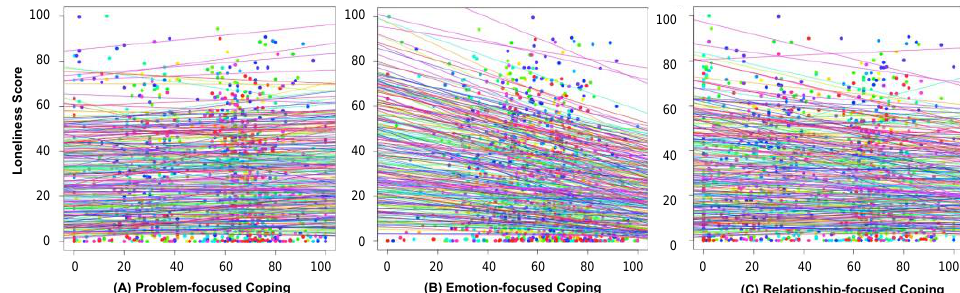
Figure 1. ( A ) Problem-focused coping was significantly associated with increased daily loneliness levels. ( B ) Emotion- and ( C ) relationship-focused coping was significantly associated with decreased daily loneliness levels. Regression lines are based on the random intercept and random slope for each individual participant and are based on seven observations for each participant.